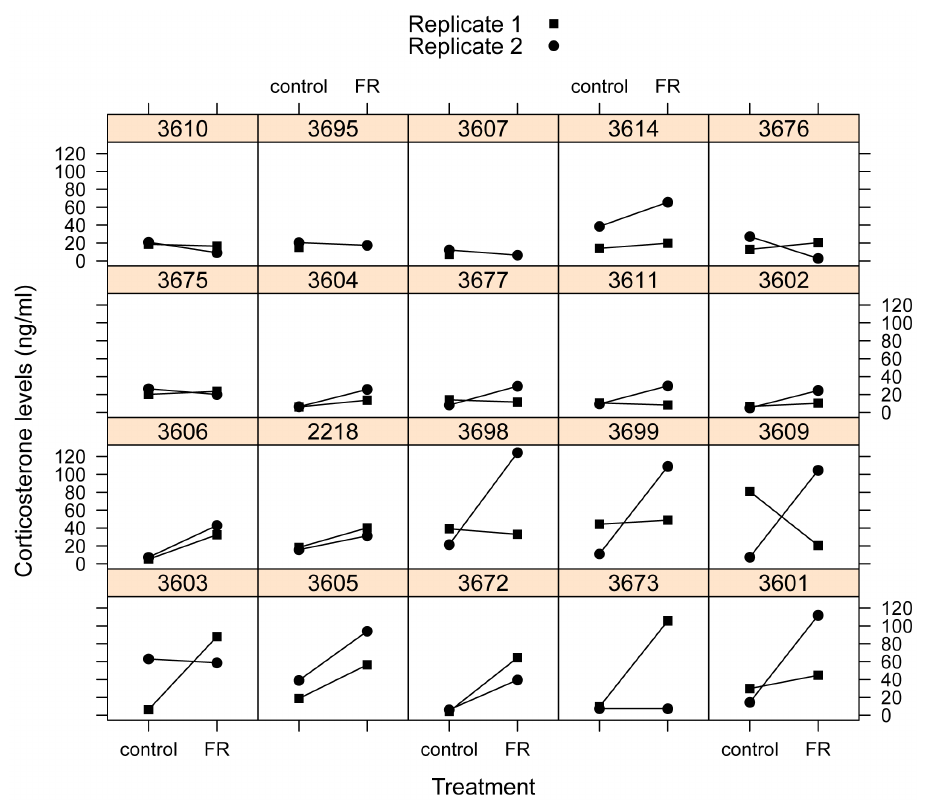
Figure 3. Corticosterone levels in response to a dietary treatment in house sparrows. The treatment was either control or food restricted (‘FR’), which corresponded to 110% or 60% respectively of daily food intake for each individuals. Each individual (denoted here by their band numbers above each box) received both treatments twice during the course of the study. Replicate 1 or 2 refers to the weeks (1–2 and 4–5 respectively) when they received the treatments. One blood sample was missed for two individuals (3607, 3695 in the top row). Individuals are ordered by degree of plasticity (after controlling for changes in their body mass), as in Fig.4.